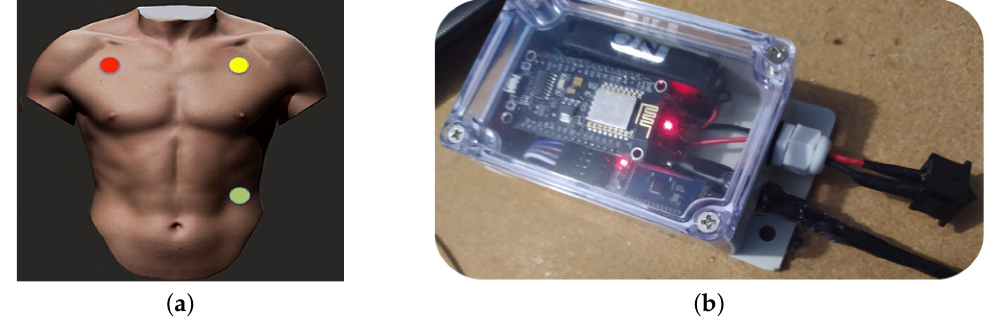
Figure 13. EcG s sensor design. ( a ) Searching for connection points and ( b ) Designing of an ergonomic